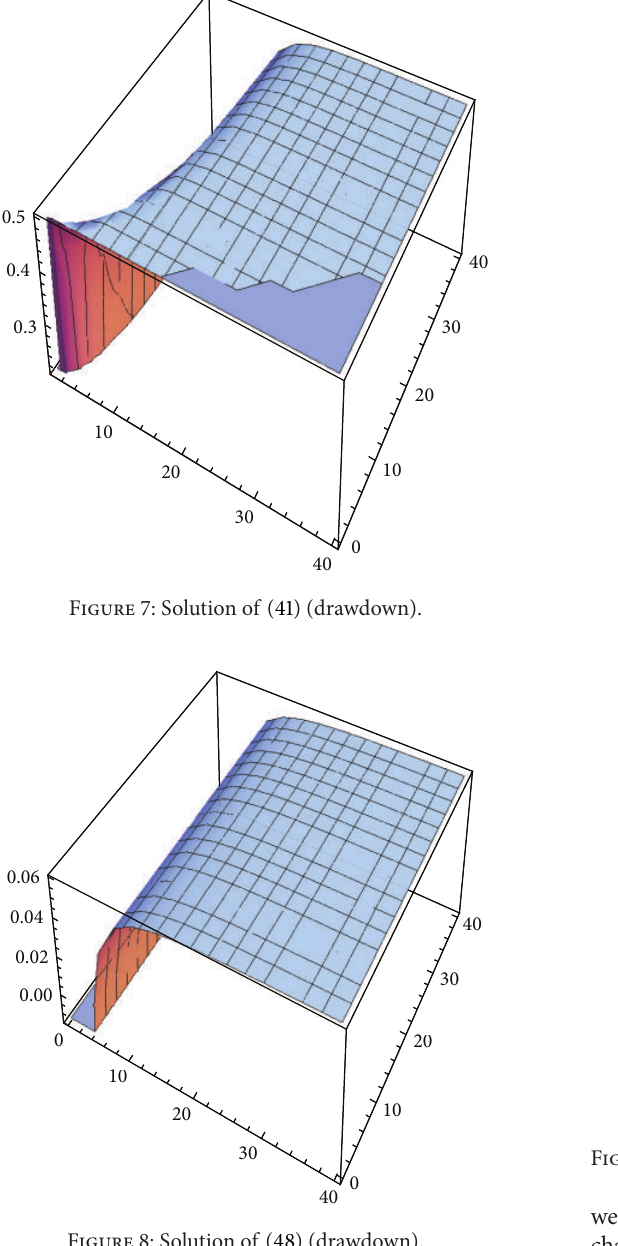
Figure 8: Solution of (48) (drawdown).